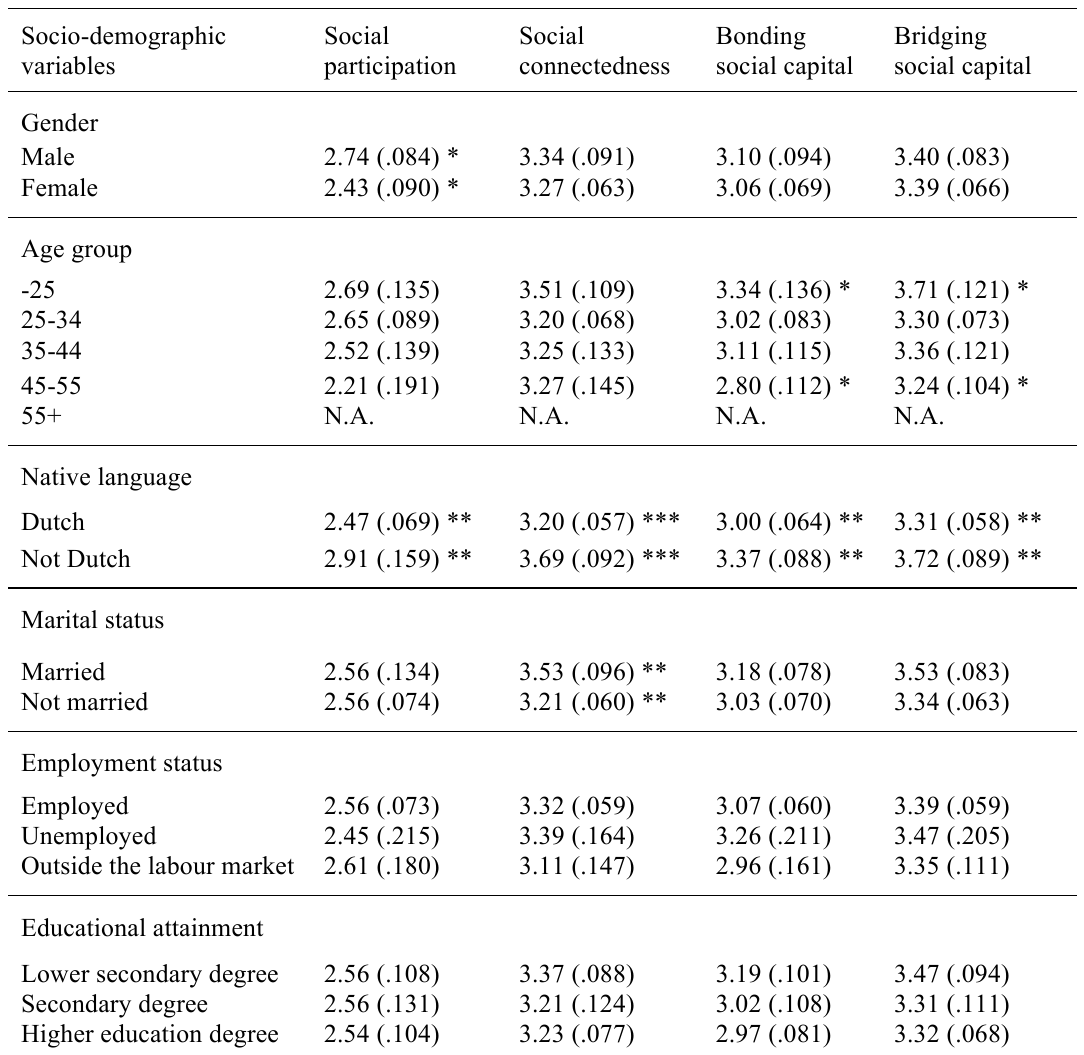
Table 7 : Group means (SE) among AEC blended adult